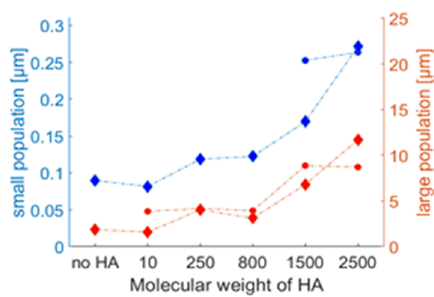
Figure 4. Mean size of the size populations of DPPC vesicles with and without HA as measured by DLS. Diamonds: 150 mM NaCl solutions. Circles: 150 mM NaCl and 10 mM CaCl 2 solutions. We note that the small size population for NaCl and NaCl/CaCl 2 coincide for no HA and the two points lie on top of each other.